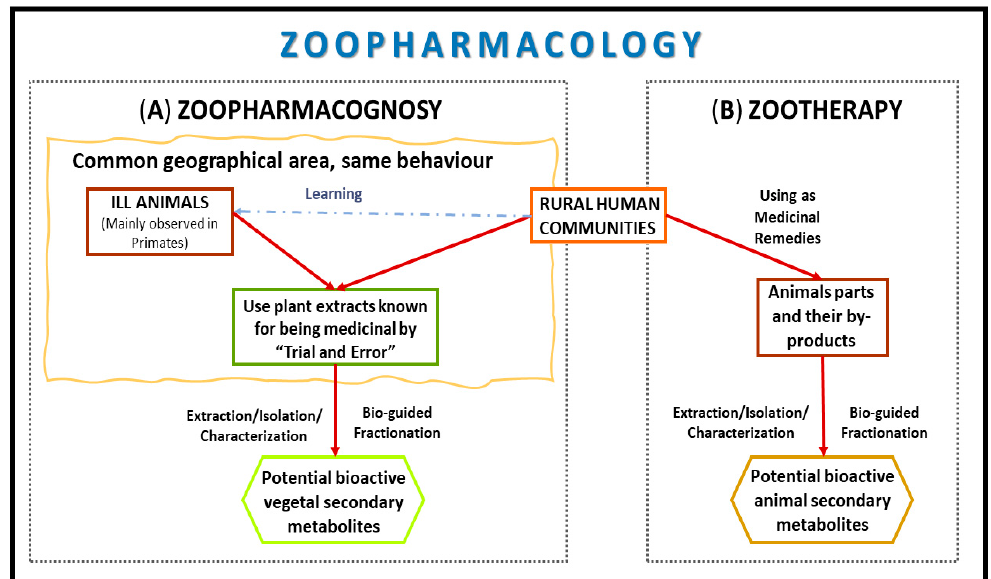
Figure 1. Zoopharmacology strategy involves drug development routes of ( A ) Zoopharmacognosy and ( B ) Zootherapy for anticancer drugs.